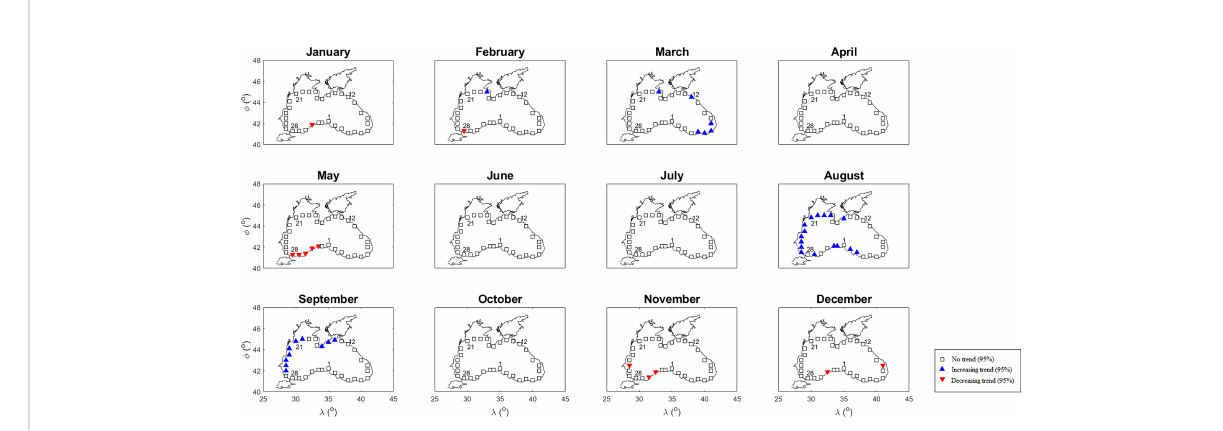
FIGURE 2 Mann-Kendall results for monthly mean SWHs during 42 years between 1979 and 2020.